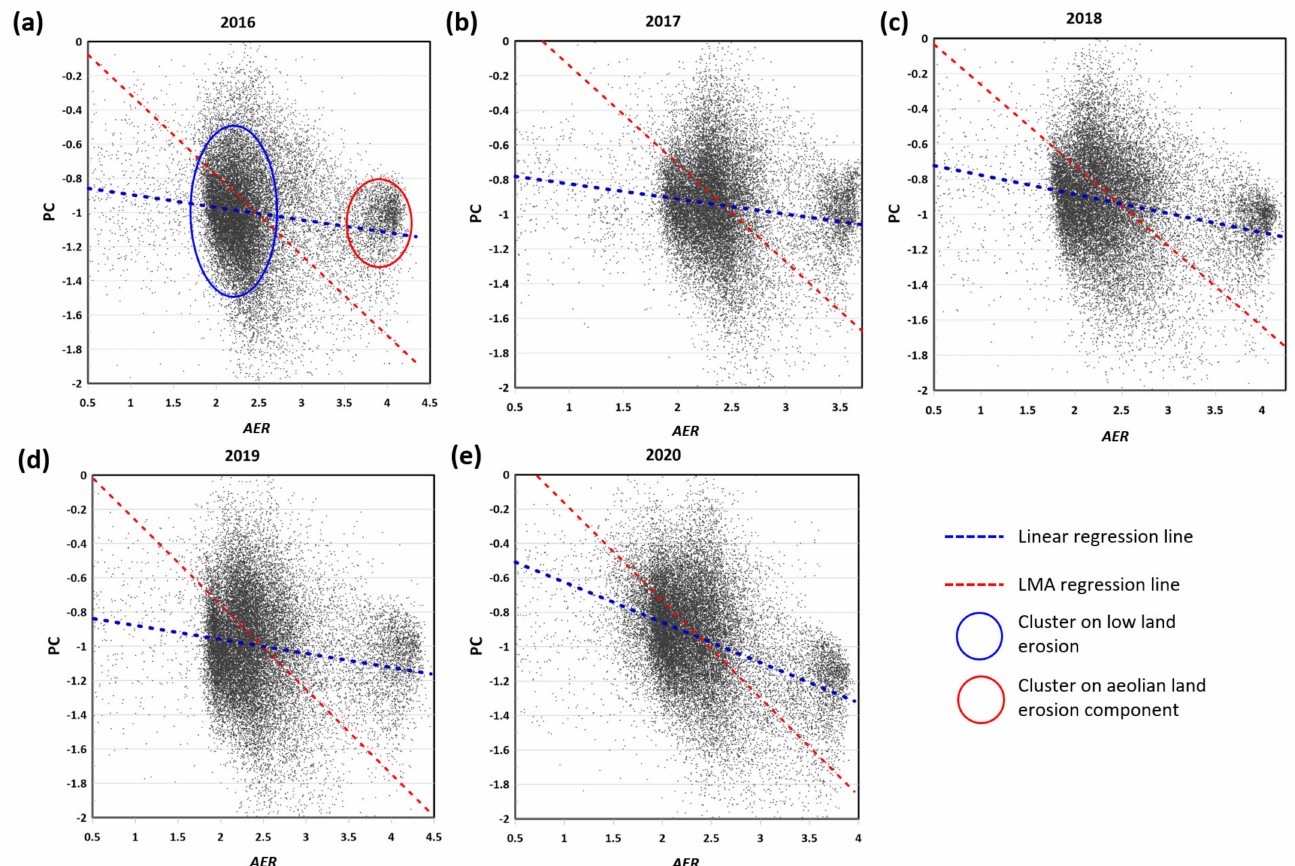
Figure 10. PC vs. InSAR AER in 2016 ( a ), 2017 ( b ), 2018 ( c ), 2019 ( d ), and 2020 ( e ). Note that the regression models between the PC and AER were built by an ordinal linear regression model (blue dotted lines) and a least mean squares (LMA) regression model (red dotted